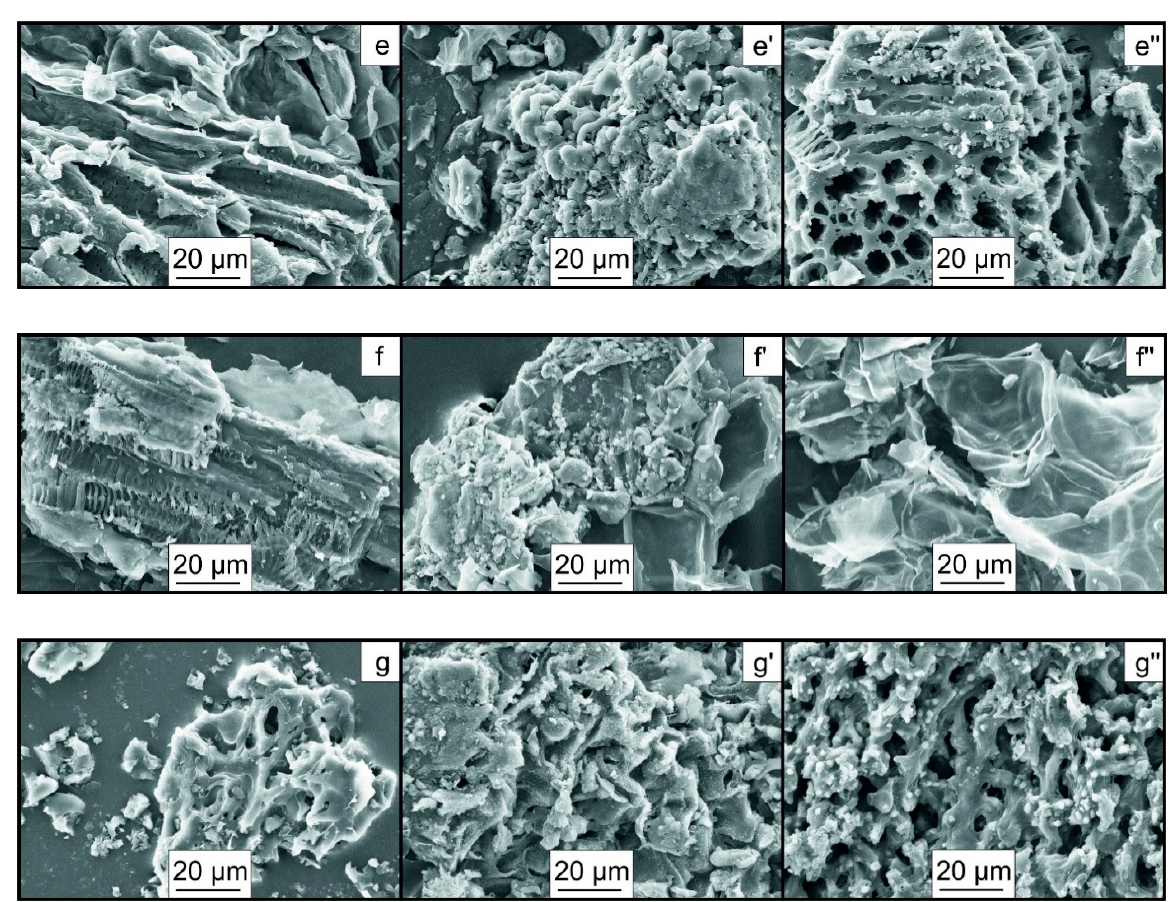
Figure 7. SEM images of the particles of the biochar samples: ( a , a’ , a’’ )—Pine400, Pine500, Pine600; ( b , b’ , b’’ )—H400, H500, H600; ( c , c’ , c’’ )—W400, W500, W600; ( d , d’ , d’’ )—M400, M500, M600; ( e , e’ , e’’ )—A400, A500, A600; ( f , f’ , f’’ )—Pean400, Pean500, Pean600; ( g , g’ , g’’ )—Pist400, Pist500, Pist600 (×1000).